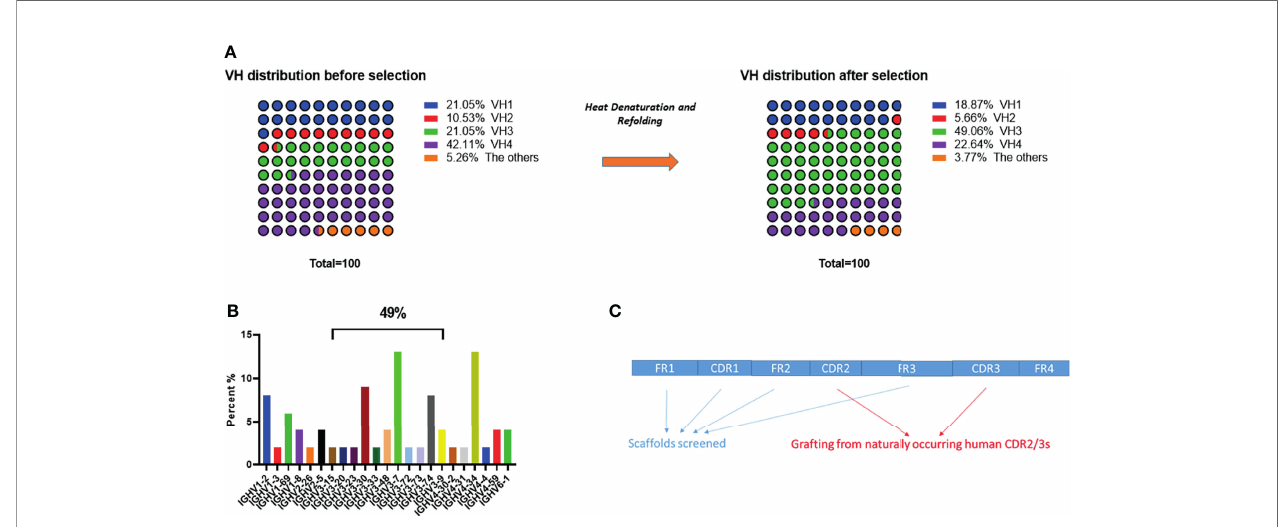
FIGURE 1 | VH segments analysis and grafting of CDR2/3s. (A) General frequency distribution of VH gene segments before and after heat denaturation and refolding screening. (B) Detailed distribution of enriched VH gene segments after heat denaturation and refolding screening. (C) Schematic view of CDR2/3